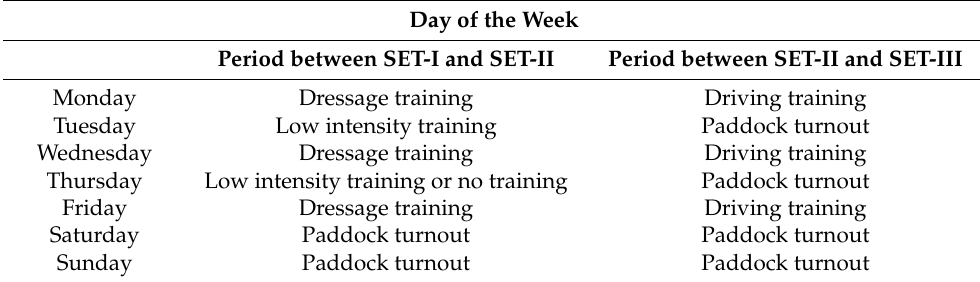
Table 1. Example of the weekly training schedule of the young Friesian horses during the 70-day test. Day of the